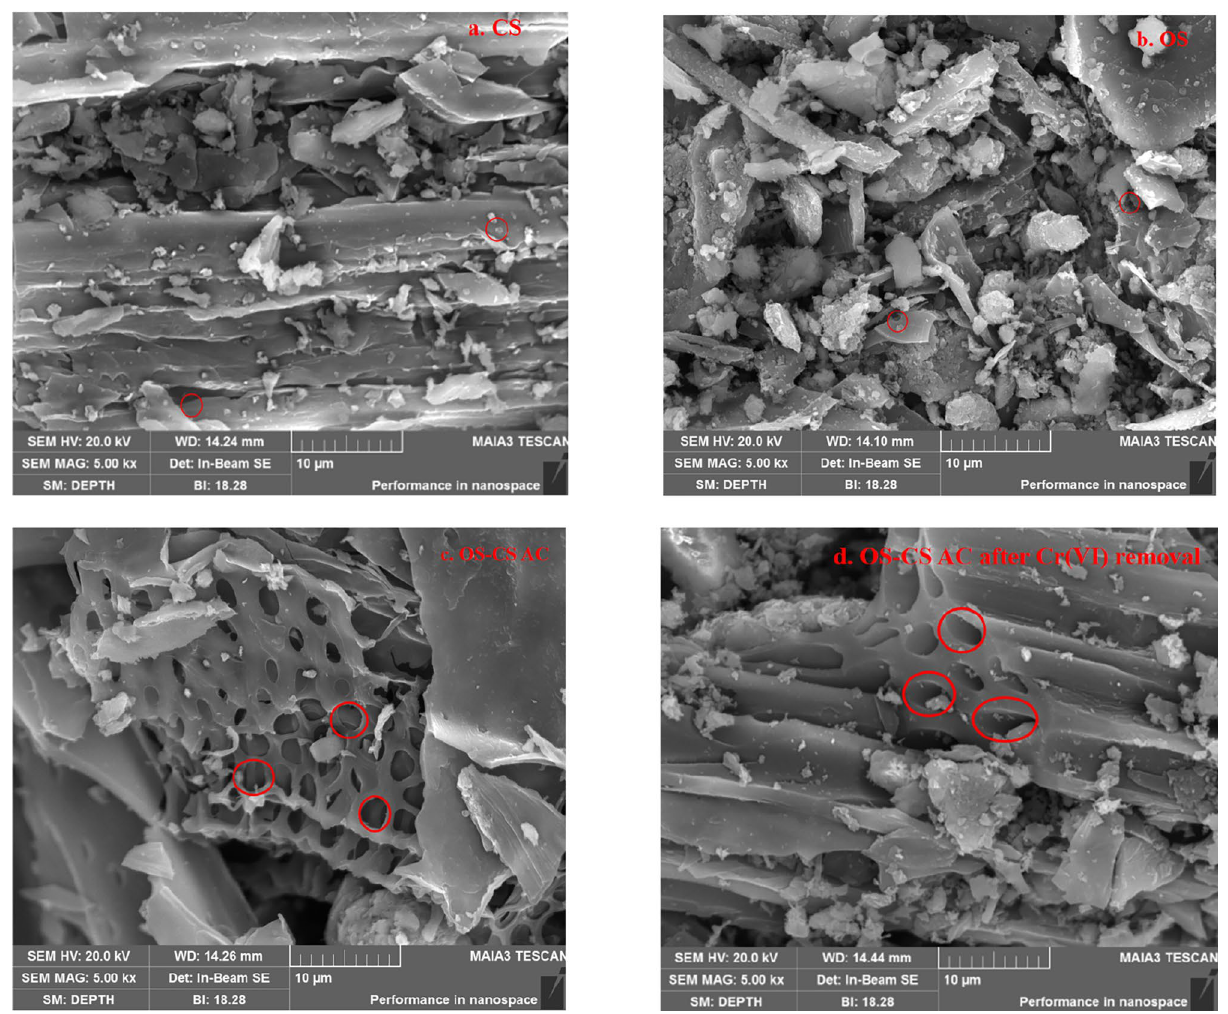
Figure 4. SEM images of CS ( a ), OS ( b ), OS-CS AC ( c ), and OS-CS AC after removal of Cr(VI) ( d ).